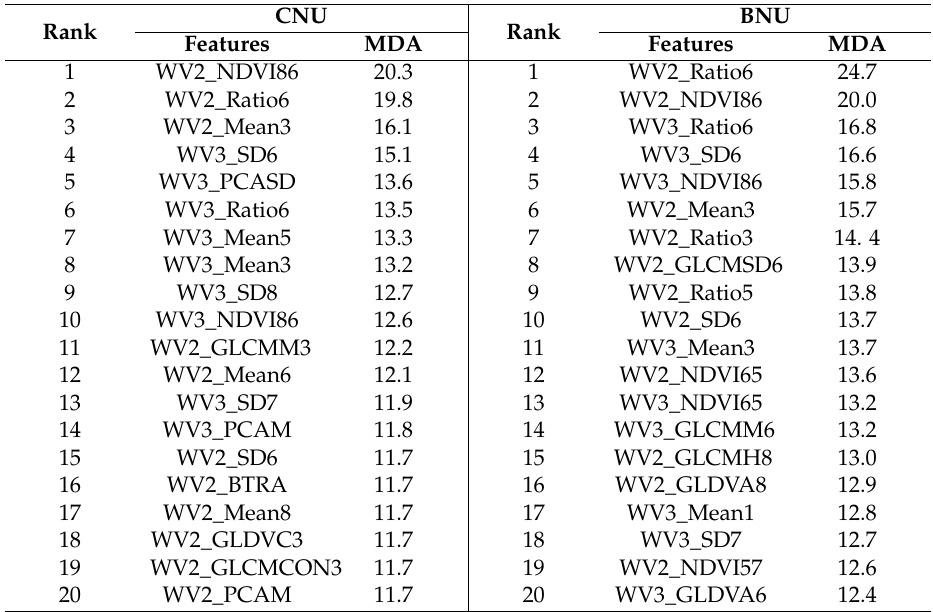
Table 9. MDA of each feature in RF for bi-temporal